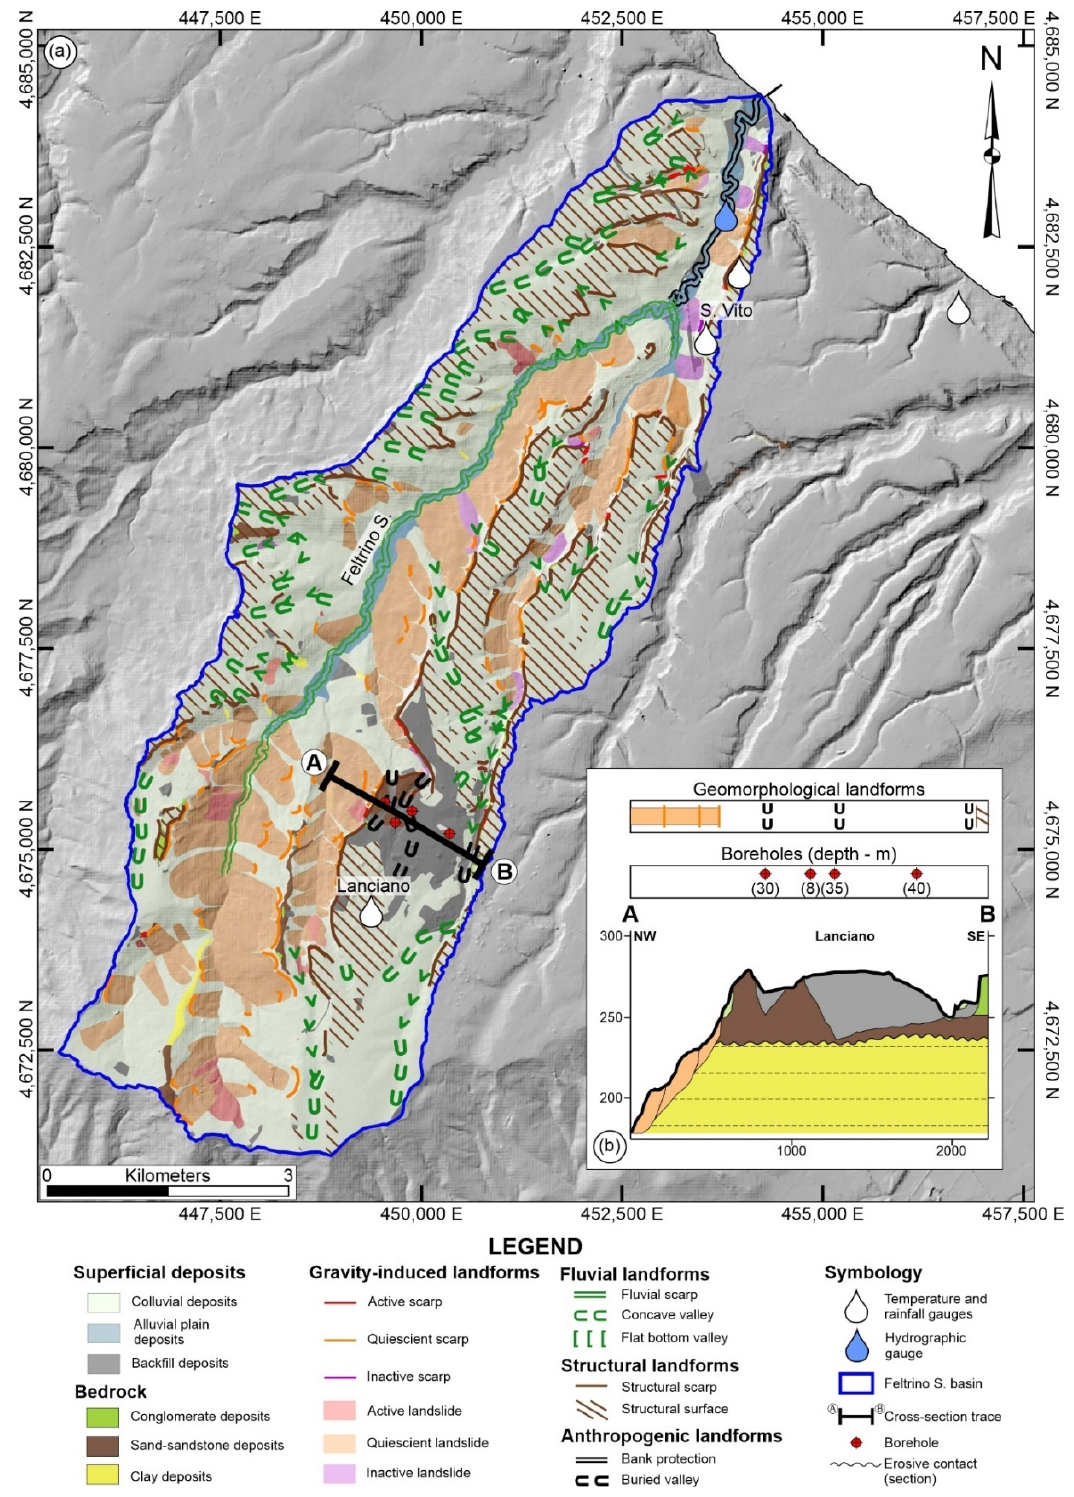
Figure 4. ( a ) Simplified geomorphological map (modified from Piacentini et al. [33]). The bedrock units are poorly outcropping at surface, while are encountered by boreholes in the subsurface and represented in the cross-section. ( b ) Schematic geomorphological cross-section (vertical exaggeration 5x; boreholes and relative stratigraphy are plotted and derived from Seismic Microzonation of the Municipality of Lanciano [60]).